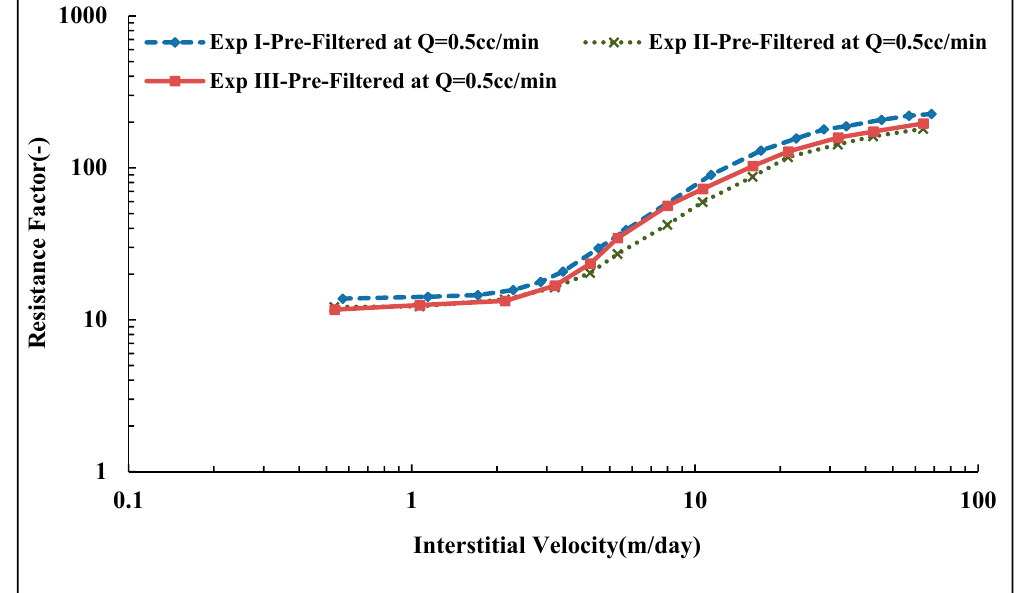
Figure 14. Reproduced resistance factor vs. interstitial velocity of pre-filtered Solution A.